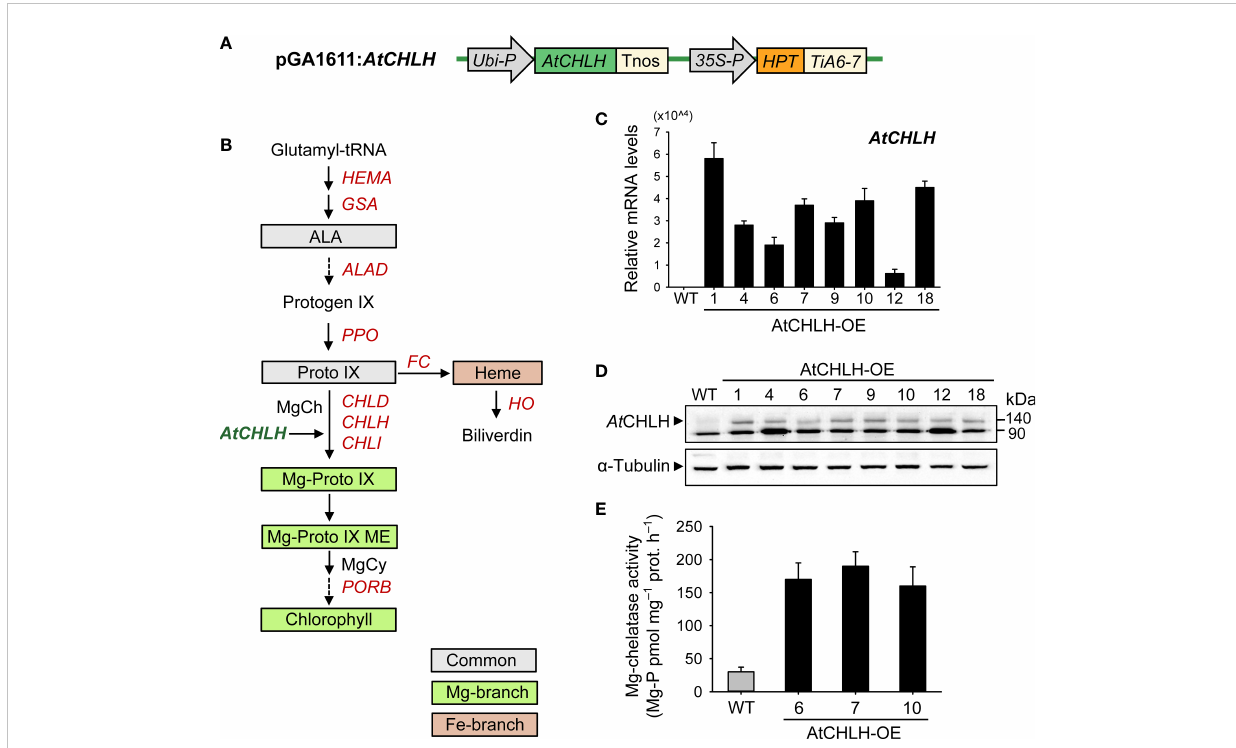
FIGURE 1 Characterization of transgenic rice plants heterologously expressing AtCHLH . (A) Schematic diagram of the T-DNA fragment in the pGA1611 binary vector. Ubi-P , maize Ubiquitin promoter; AtCHLH , Arabidopsis thaliana Mg-chelatase H subunit gene; Tnos , nopaline synthase terminator; 35S, cauli fl ower mosaic virus 35S promoter; HPT , hygromycin phosphotransferase ; TiA6-7 , terminator of TiA6-7 which is a T-DNA gene in Agrobacterium tumefaciens . (B) The porphyrin biosynthetic pathway in plants showing intermediates and genes analyzed in this study. MgCy, Mg-Proto IX ME cyclase. (C) Expression of AtCHLH in leaves of transgenic lines, as determined by RT-qPCR analysis. Actin was used as an internal control. (D) Immunoblot analysis of At CHLH in leaves of transgenic lines, using an antibody against At CHLH. Alpha - tubulin was used as a loading control. (E) Mg-chelatase activity in WT plants and transgenic lines expressing AtCHLH . Mg-P, Mg-Proto IX; prot, protein. Values are means ± SE, and data from three independent experiments are presented. WT and transgenic rice plants were grown in the greenhouse under optimal conditions for 4 weeks. WT, nontransgenic wild-type rice; AtCHLH-OE1 – 18, transgenic rice lines overexpressing AtCHLH